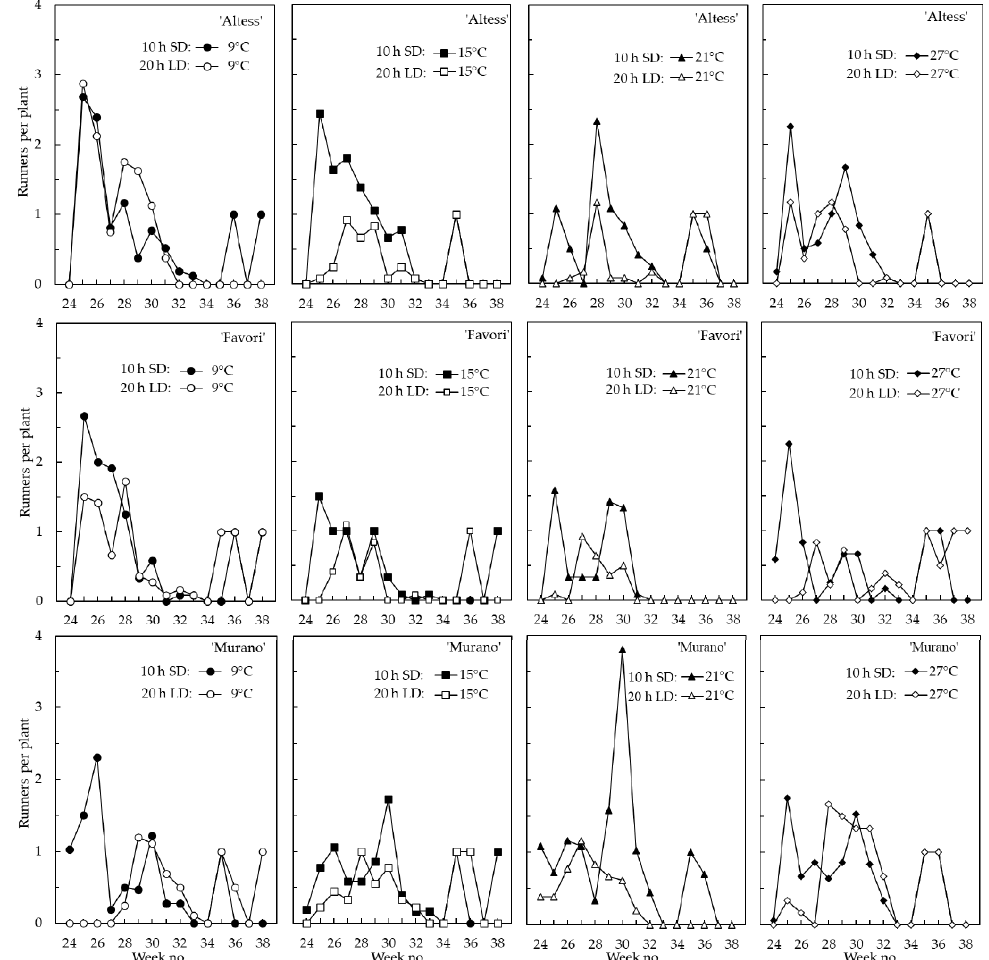
Figure 6. Time courses of weekly runner production of three EB strawberry cultivar as affected by 4 weeks of preconditioning at temperatures of 9 °C, 15 °C, 21 °C, 27 °C and 10 h or 20 h photoperiods, followed by further raising under natural outdoor conditions from 12 September until 24 October 2018. The plants were cropped in a plastic tunnel after overwintering in cold storage at − 1.5 °C from 24 October 2018 until 5 May 2019. The data are means of three replications with four plants each.